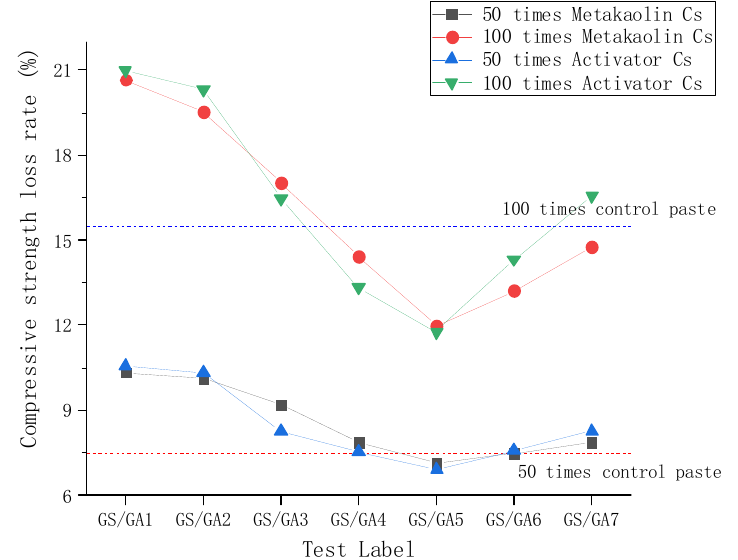
Figure 7. Compressive strength loss rates after 50/100 times of GS/GA and cement control pastes.